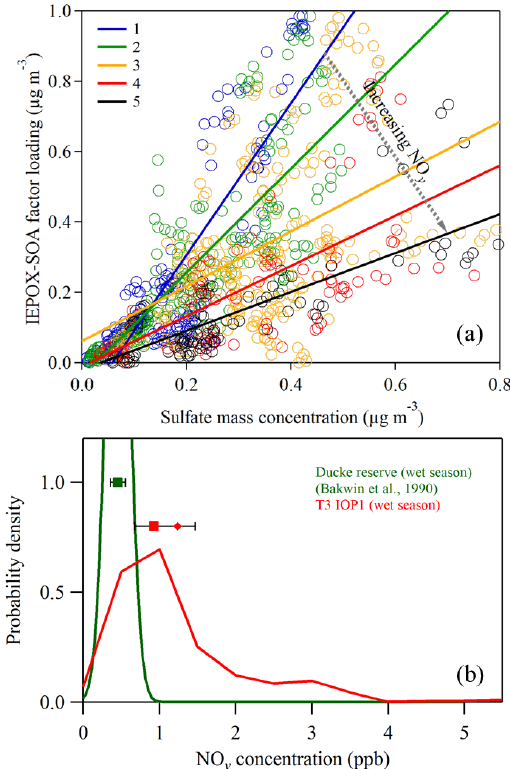
Figure 6. (a) Scatter plot of sulfate mass concentration and IEPOX- SOA factor loading for local afternoon (12:00–16:00 local time; 16:00–20:00UTC). The data sets were collected into five subsets, colored and labeled 1 to 5, based on NO y concentration. Table 1 presents the parameters of the five least-squares linear fits repre- sented by the colored lines in the figure. (b) Probability density function of NO y concentration at a background site nearby Manaus in the wet season of 1987 (Bakwin et al., 1990) and at T3 during the wet season of 2014 (IOP1) (afternoon data). Means (diamonds), medians (squares), and interquartile range (whiskers) are shown for the probability density functions. Additional analysis of (a) is pre- sented in the Supplement (Sect. S5) related to Fig.